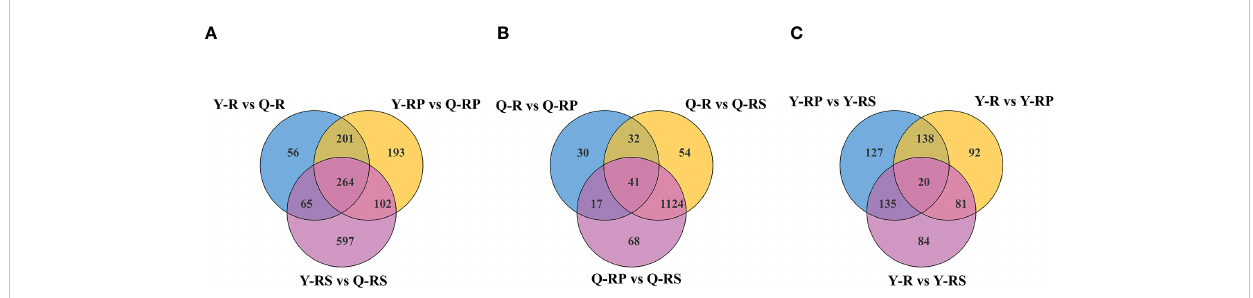
FIGURE 7 Plotted Venn diagram of the different metabolites in the above comparison groups from raspberries, Y-R vs Q-R, Y-RP vs Q-RP, and Y-RS vs Q-RS Venn diagram, (A) ; Q-R vs Q-RP, Q-R vs Q-RS, and Q-RP vs Q-RS, (B) ; Y-R vs Y-RP, Y-R vs Y-RS, and Y-RP vs Y-RS, (C) , were plotted using Venn diagram package.